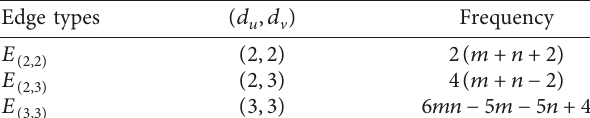
Table 2: Edge Partition of O